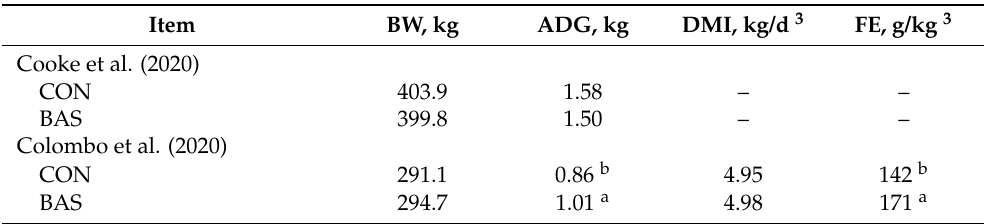
Table 3. Mean post-feedlot entry performance in beef cattle receiving (BAS) or not (CON) a bovine appeasing substance 1,2 . Item